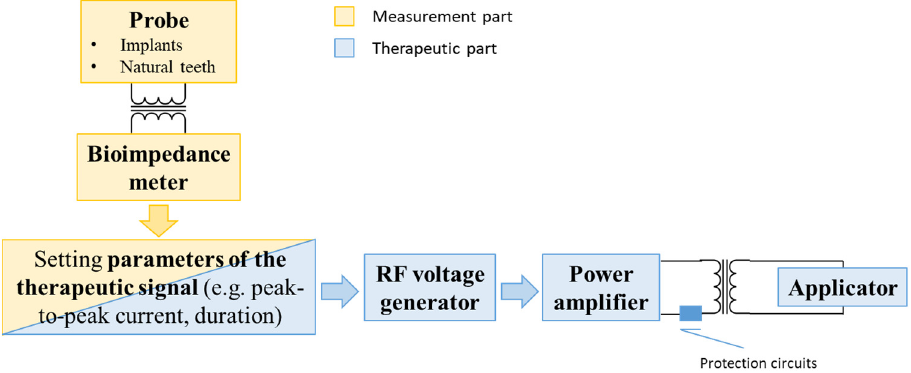
Figure 1. Block diagram of the device.